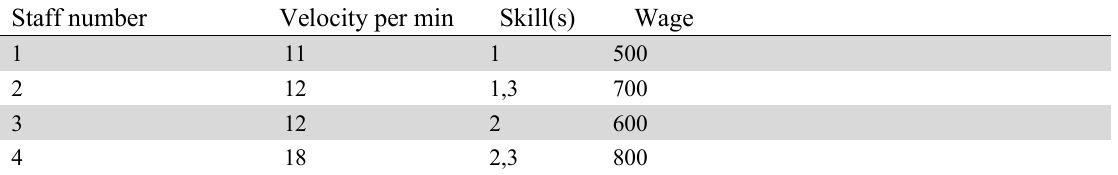
Information of staffs